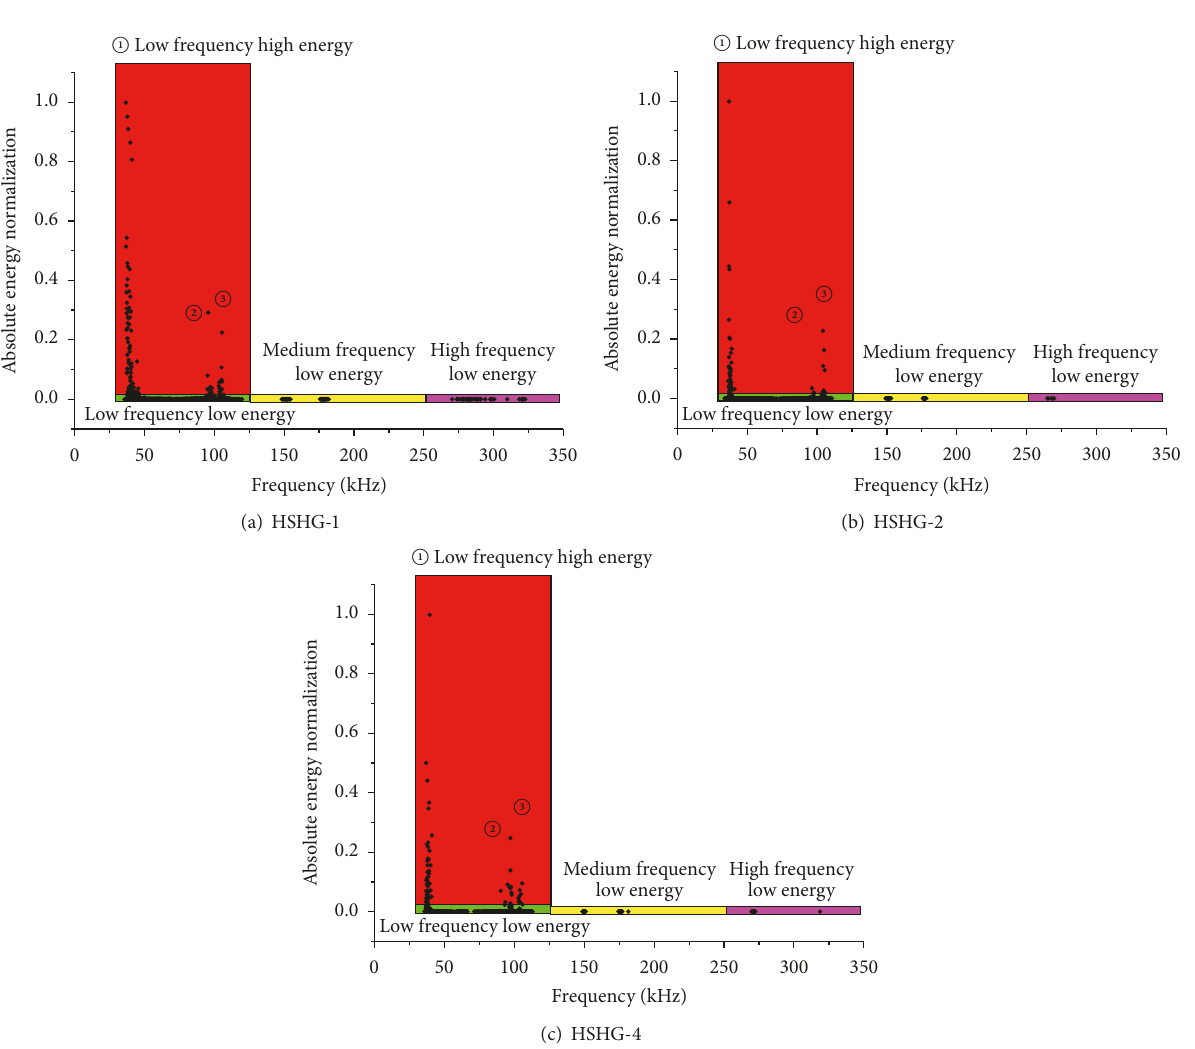
emission energy of the rock fracture process are proportional and are inversely proportional to the acoustic emission dominant-frequency. Low frequency high-energy acoustic emission signals often correspond to large-scale fractures; high frequency low energy acoustic emission signals often correspond to small-scale fractures. The studies of Santis and Tomor indicate that high-amplitude waveform signals are usually concentrated in low frequency regions, which forebodes the high-energy release [37]. It is consistent with the analysis results of large-scale fractures corresponding to slow-frequency high-energy